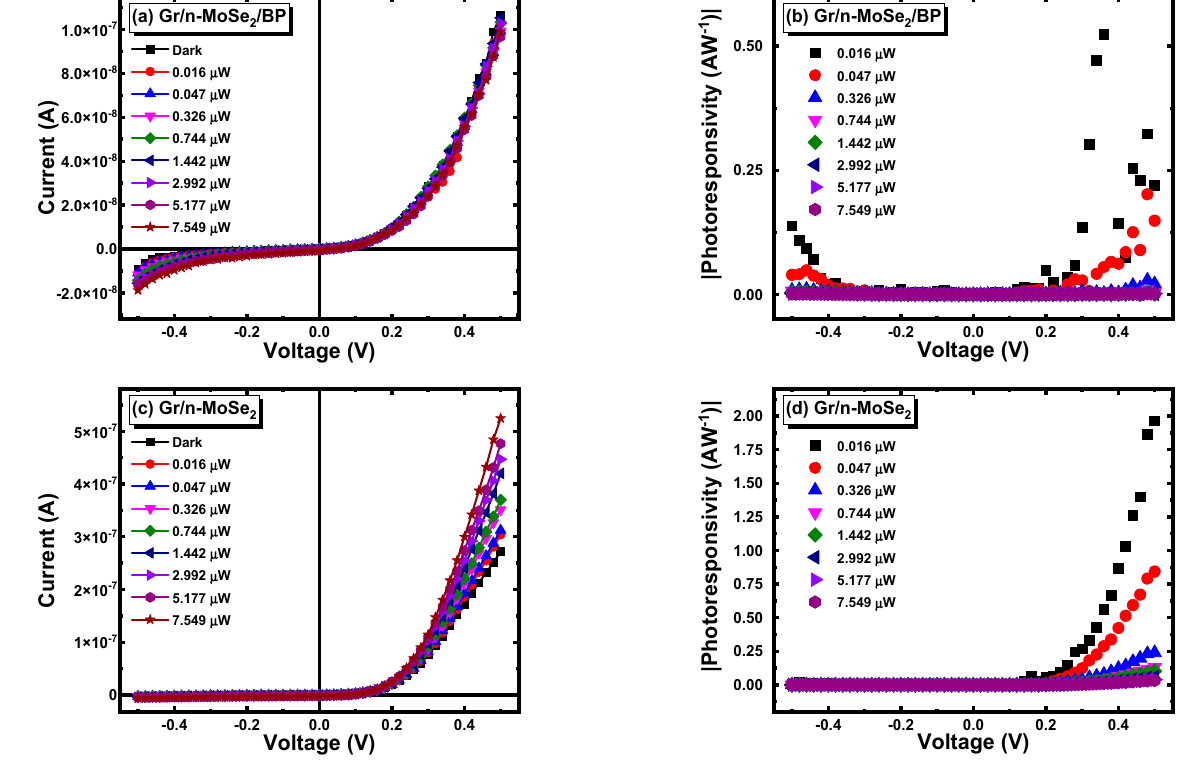
Figure 3. Laser power dependence of output characteristics of ( a ) Gr/n-MoSe 2 /p-BP and ( c ) Gr/n- MoSe 2 heterojunctions, and ( b , d ) their corresponding absolute values of photoresponsivity. Figure 4a shows the output characteristics in the dark condition of n-MoSe 2 /p-BP when MTL Gr was used as the gate. The current (I ds or I 32 ) and voltage (V ds or V 32 ) were measured between contacts (2) and (3), and the gate voltage (V 1 ) was applied at contact (1) (see Figure S3a). As shown in Figure 4a, the n-MoSe 2 /p-BP heterojunction indicated a p-type channel, which implies that the transport was dominated by holes in the valence band in BP (Figure 2b,c). The shift in the drain–source voltage to negative values as the gate voltage increased, as observed in the n-MoSe 2 /p-BP heterojunction and illustrated in the inset of Figure 2a, was due to the leakage current between the multilayered Gr and MoSe 2 flakes. Figure 4b shows the output characteristics in the dark condition of Gr/n-MoSe 2 when MTL BP was used as the gate. The current (I ds or I 12 ) and voltage (V ds or V 12 ) were measured between contacts (1) and (2), and the gate voltage (V 3 ) was applied at contact (3) (see Figure S4a). The Gr/MoSe 2 heterojunction indicated an n-type channel; therefore, the transport was dominated by electrons accumulated at the SiO 2 /n-MoSe 2 interface and in the multilayered n-MoSe 2 (Figure 2a). As illustrated in the inset of Figure 4b, the device indicated an extremely low leakage current and a high on/off current (I on /I off = 6.3 × 10 3 at a gate voltage of 0.5 V), which can be explained by the potential barrier between n-MoSe 2 and p-BP (see Figure 2c). It is noteworthy that both Gr/n-MoSe 2 and n-MoSe 2 /p-BP were in the accumulated mode, as shown in Figure 2a,b.